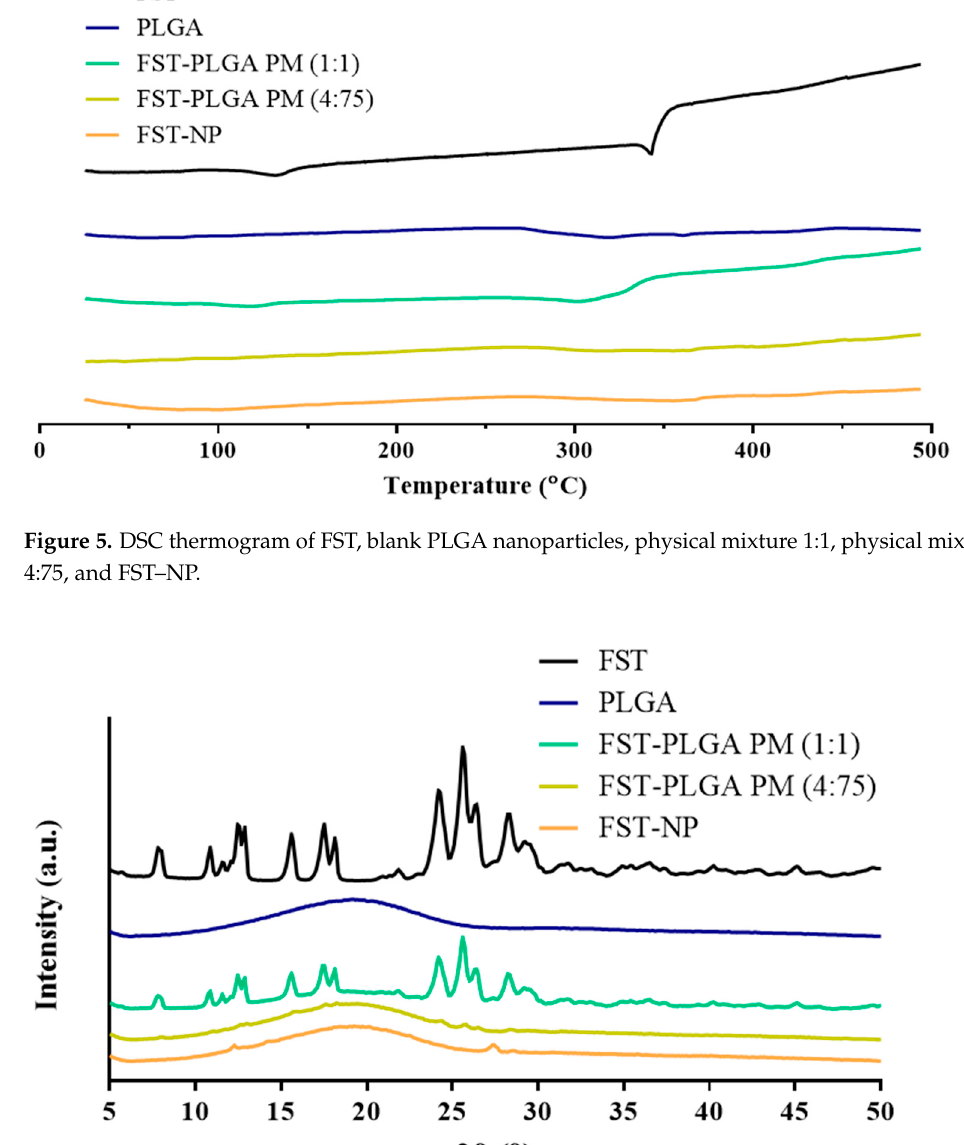
Figure 5. DSC thermogram of FST, blank PLGA nanoparticles, physical mixture 1:1, physical mix- ture 4:75, and FST–NP.